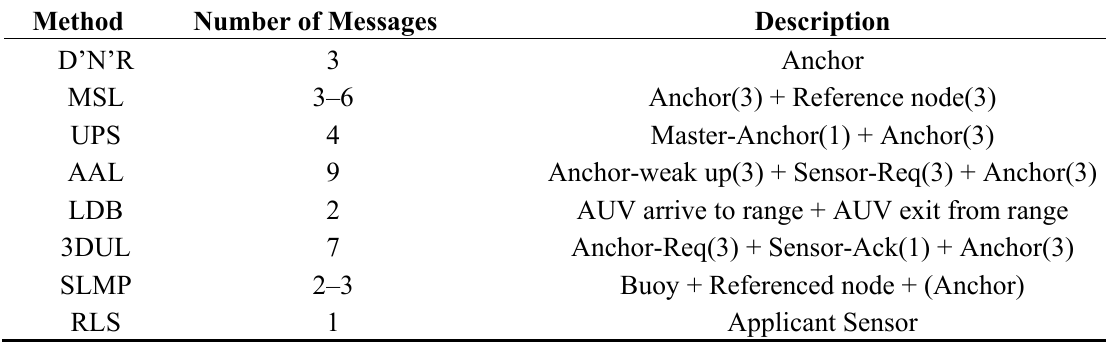
Table 3. Communication